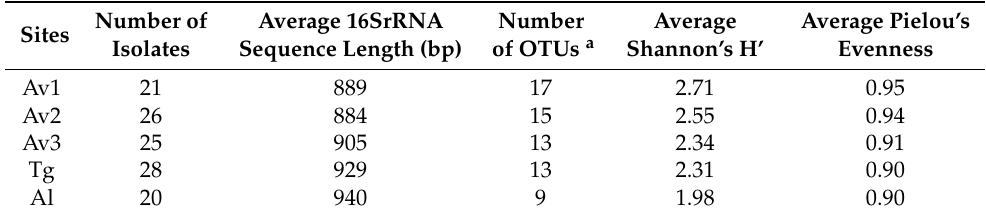
Table 2. Diversity of the subsets of isolates, based on the analysis of 16S rRNA gene partial sequences.